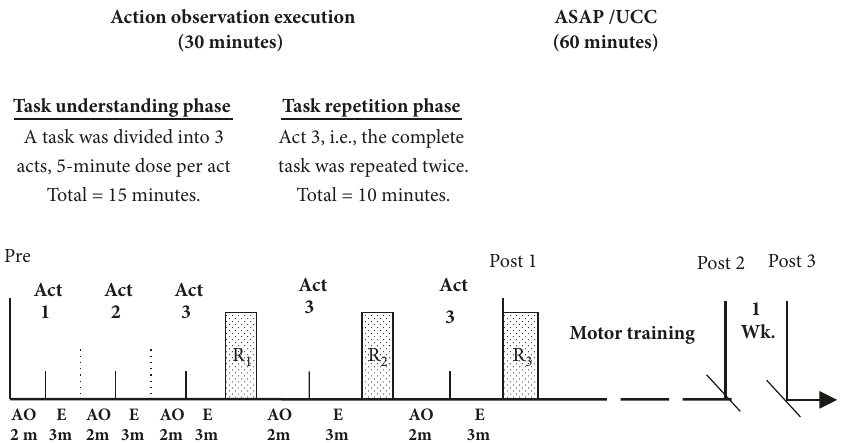
Figure 2: Intervention structure with timeline diagram of action-observation-execution. AO: action-observation, E: execution, ASAP: accelerated skill acquisition program, UCC: usual and customary care, m: minutes, R1 and R2: rest time between repetitions = 5 minutes, R3: rest time between interventions = 10 minutes, Wk.: week. Act 1: reach and grasp a glass/bottle/cup with the affected hand; return to the starting point. Act 2: reach, grasp, and raise a glass/bottle/cup toward the mouth with the affected hand; return to the starting point. Act 3: reach, grasp, and raise a glass/bottle/cup toward the mouth with the affected hand and drink; return to the starting